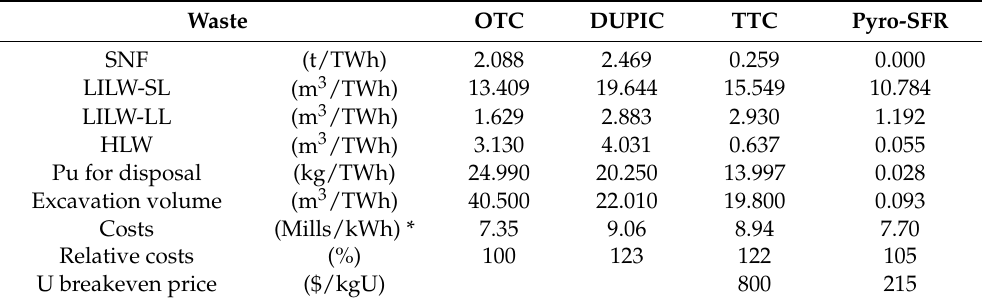
Table 11. Results of Korean material flow and economic modelling studies [53,71] for four example systems.